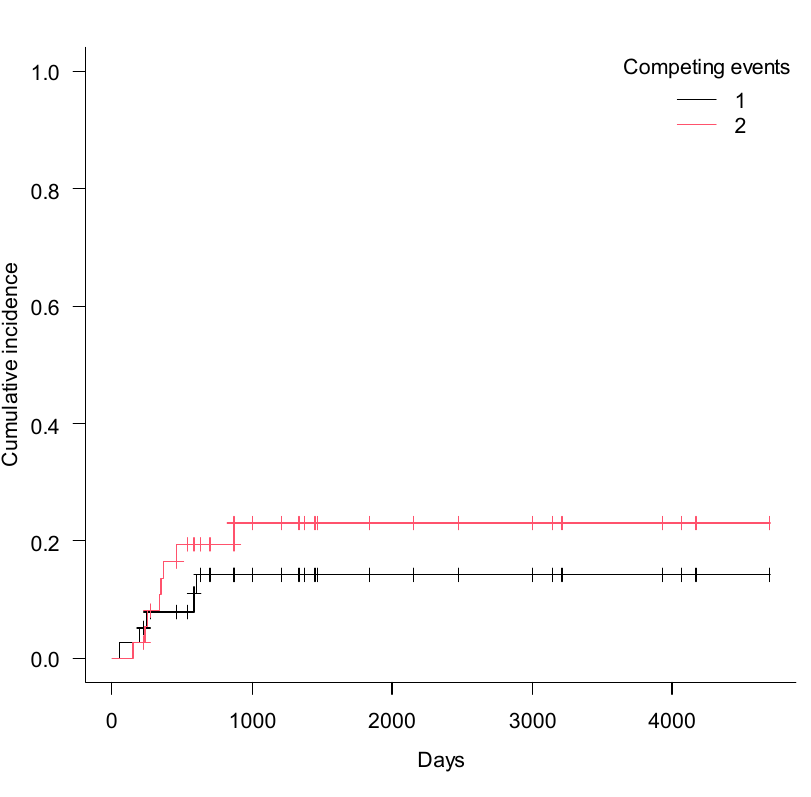
Figure 2. Non-relapse mortality (1) and cumulative incidence of relapse (2) in children with cGVHD after ECP.